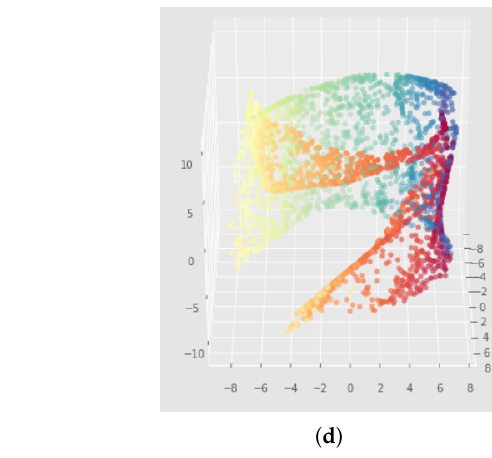
Figure A3. Worse results of the Witness Simplicial VAE applied to the open cylinder after 200 epochs, each row is a different neural network initialization: latent representations of the training set on the left and corresponding reconstruction on the right. Hyper parameters: batch size = 128, 10 landmarks, r filtration = 6, weights w SE = w SD = 10. ( a ) Latent representation. ( b ) Reconstruction. ( c ) Latent representation. ( d )